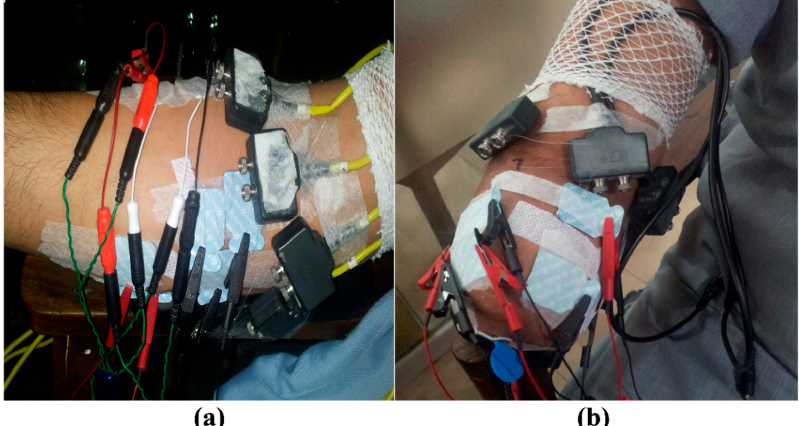
Figure 1. Electrodes placement for ( a ) able-bodied subject and ( b ) transradial amputee. For intramuscular electromyography (iEMG), six pairs of wire were inserted into the flexor carpi radialis, palmaris longus muscle, flexor digitorum superficialis, extensor carpi radialis longus, extensor digitorum and extensor carpi ulnaris. Six surface EMG (sEMG) electrodes were placed beside